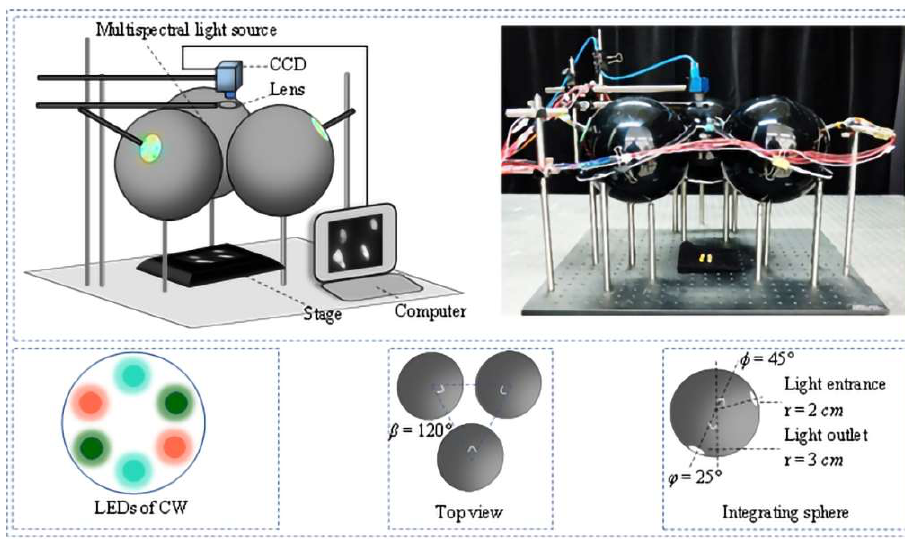
Figure 3. Structure of multispectral image acquisition system.